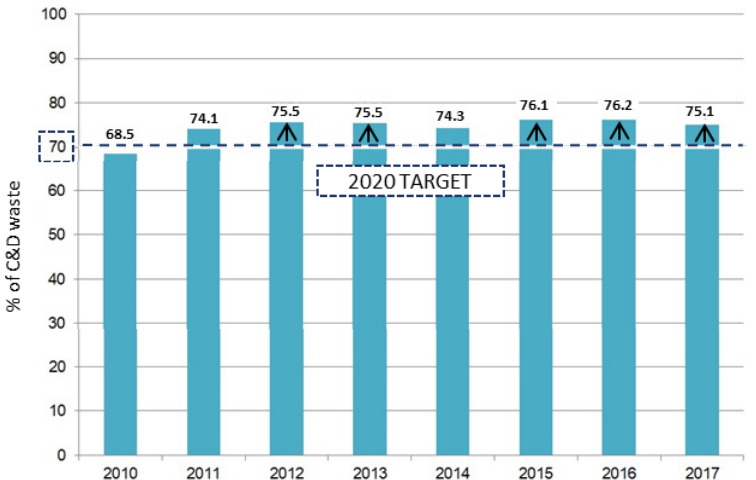
Figure 6. Preparation for reuse, recycling and other forms of material recovery, excluding backfilling. Source: Own elaboration with ISPRA data.